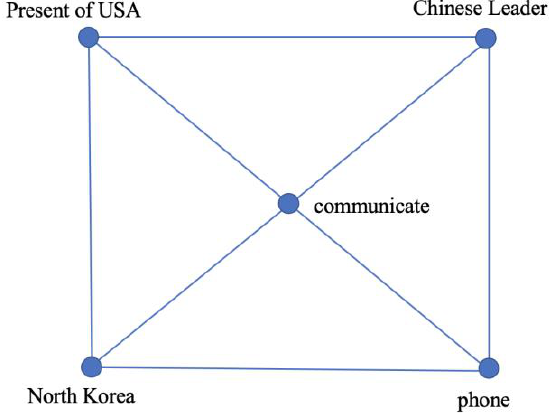
Figure 1. The polygon formed from the example sentence.